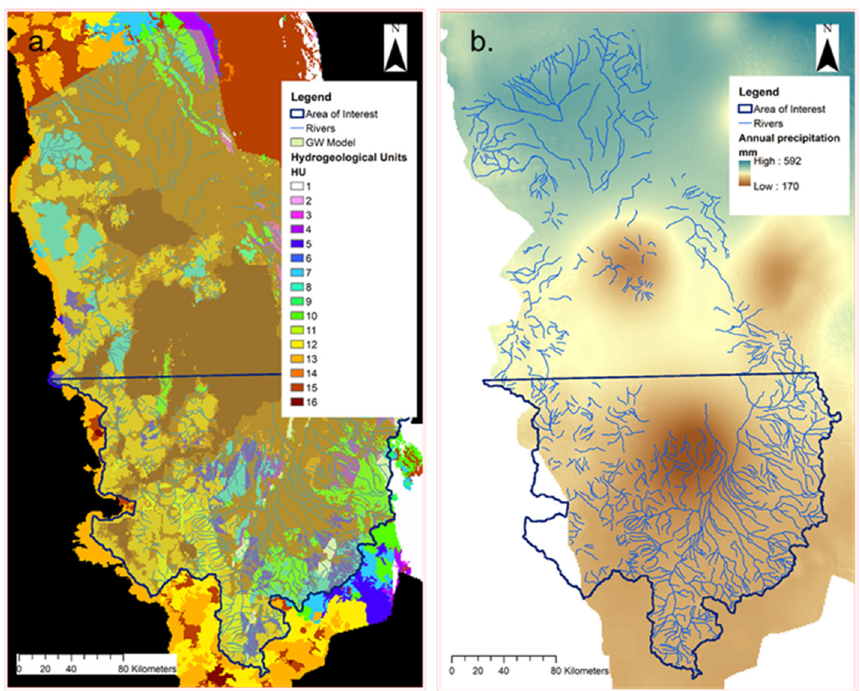
Figure 11. MODFLOW modelling. ( a ) Model setup with HUs (see Appendix A), model extent, and rivers; ( b ) long-term average rainfall.